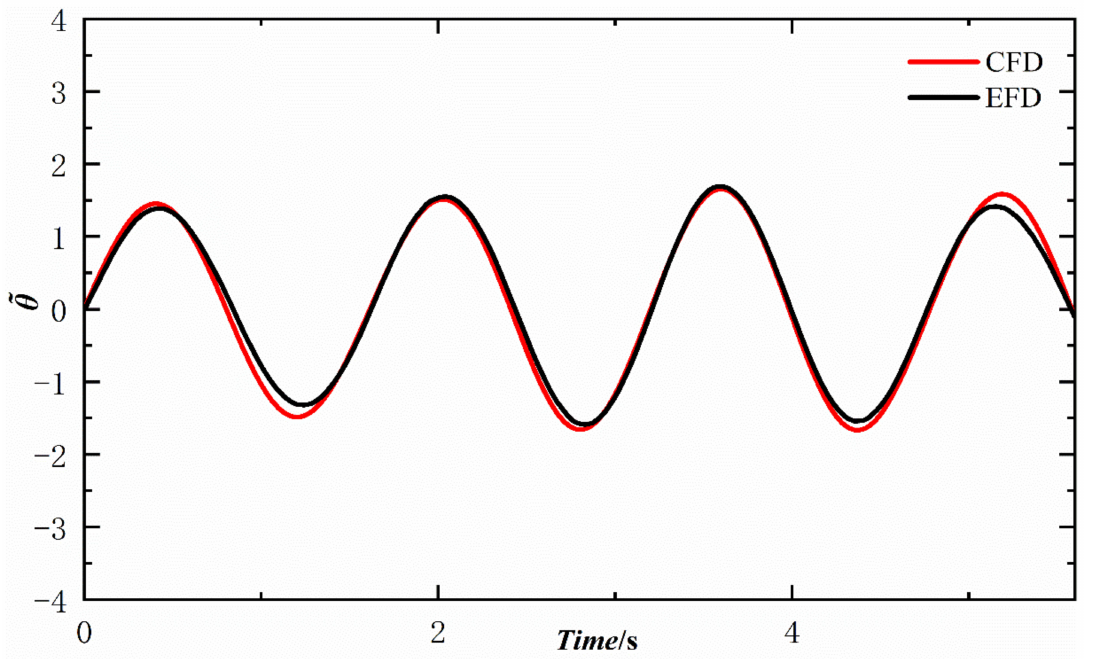
Figure 11. Comparison of the roll angle of ship with tank between CFD and EFD at a wavelength ratio of 1.334 and a tank length of 1.17 m.